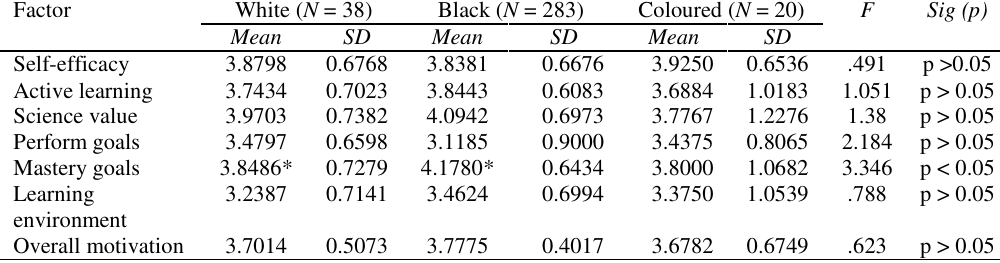
Table 2 Means and standard deviations of three racial groups on six motivation factors Factor